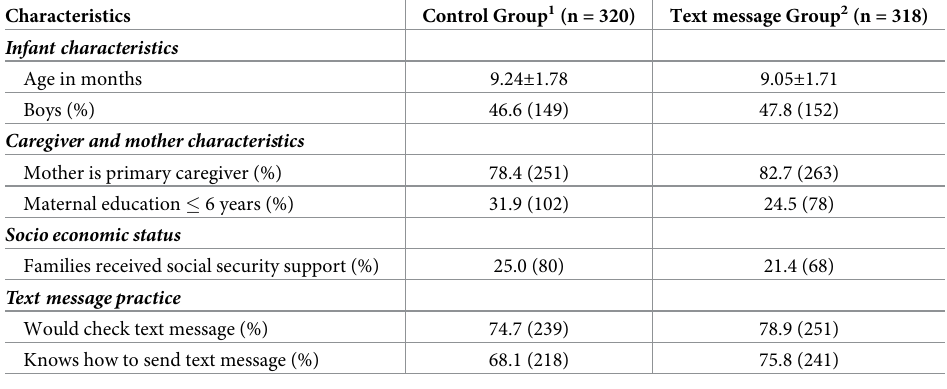
Table 1. Baseline characteristics of sample infants, caregivers, household social economic status, and primary caregivers’ text message practice by trial groups: Rural Shaanxi Province, China, 2013.